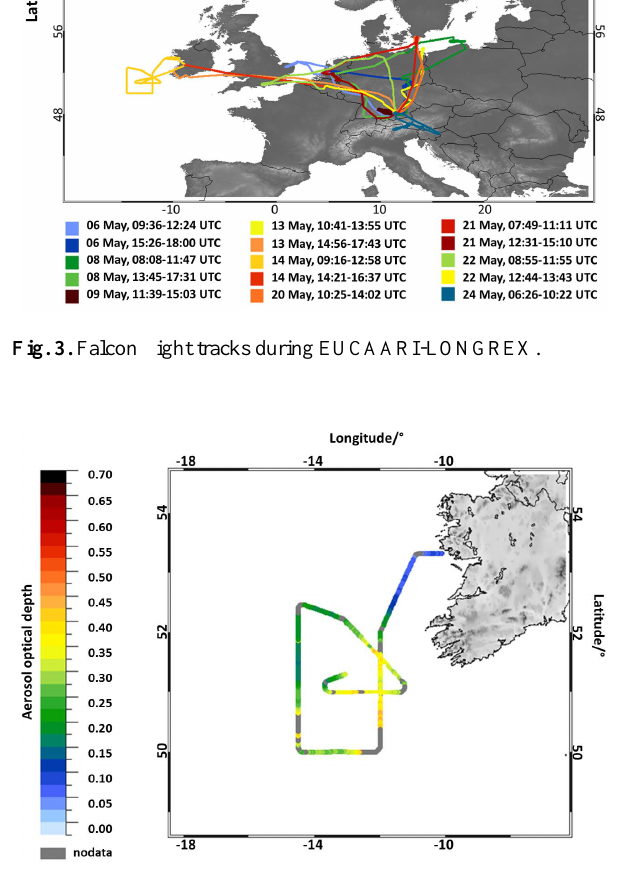
Fig. 4. AOD at 532nm along the Falcon flight track south-west of Ireland on 14 May 2008. “Nodata” marks areas in which the calcu- lation of AOD was prevented by clouds, or by biased measurements caused by spiralling.